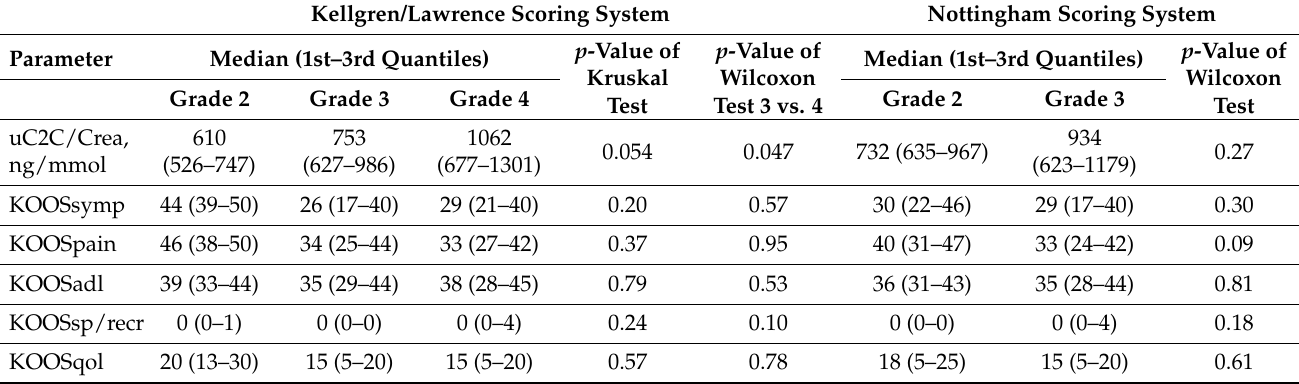
Table A2. The associations between radiographic findings and uC2C levels or clinical parameters.